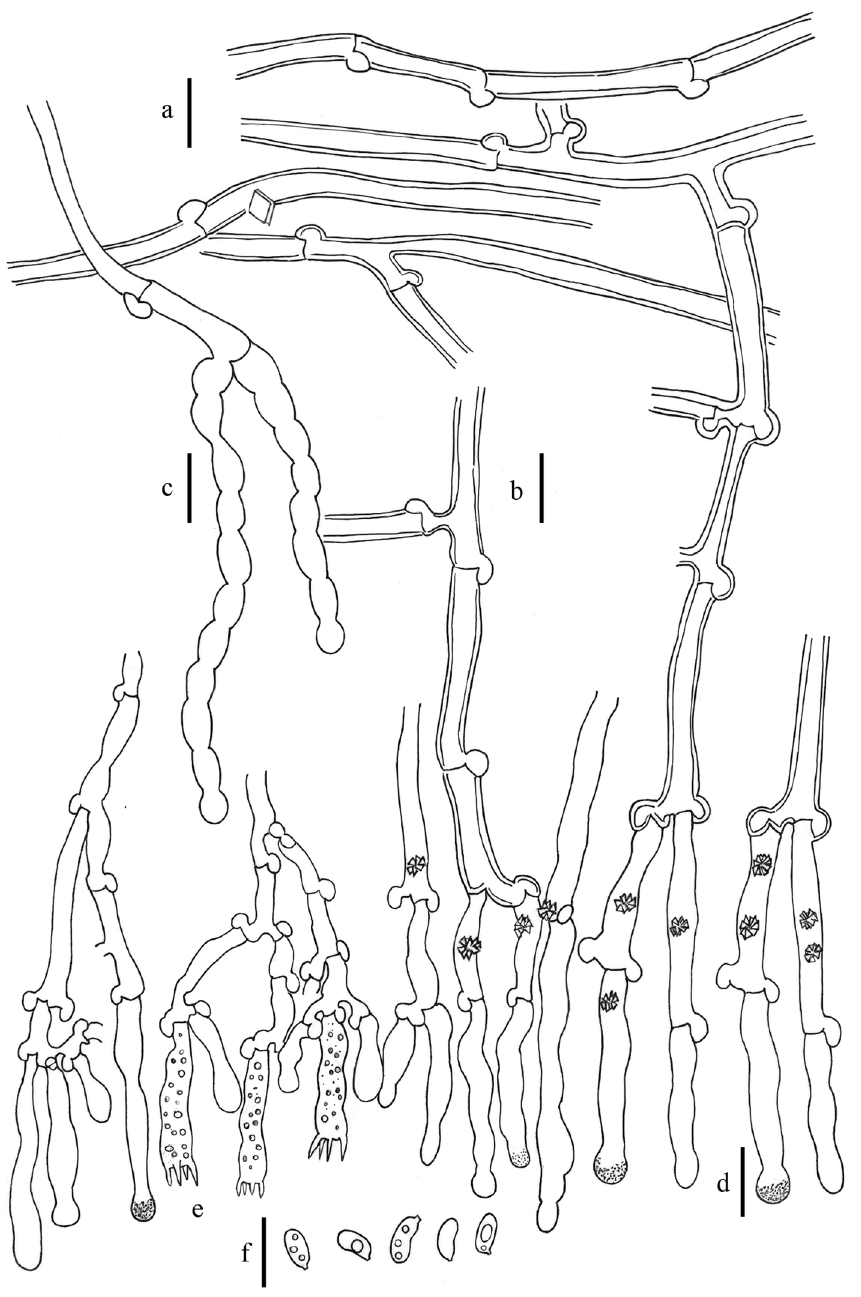
Figure 4. Xylodon magallanesii , 20008Tell, MA-Fungi 90397, holotype. ( a ) Subicular hypha. ( b ) Subhymenial hypha. ( c ) Moniliform cystidia. ( d ) Claviform cystidia. ( e ) Basidia. ( f ) Basidiospores. Bar = 10 µm. Hand-made draws were edited using GIMP v2.10.20 (https